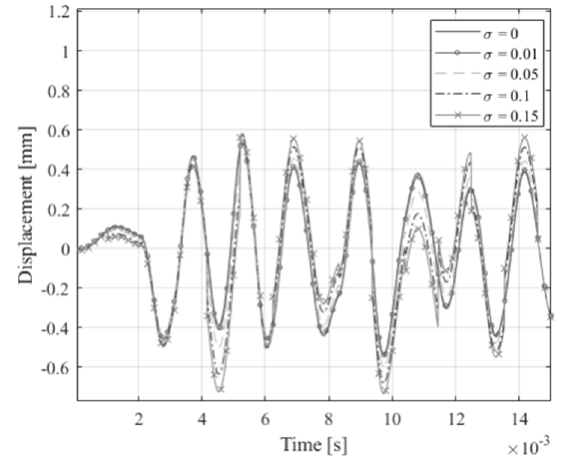
Figure 4. Comparison of the displacement x sim ( t ) at different measurement errors.